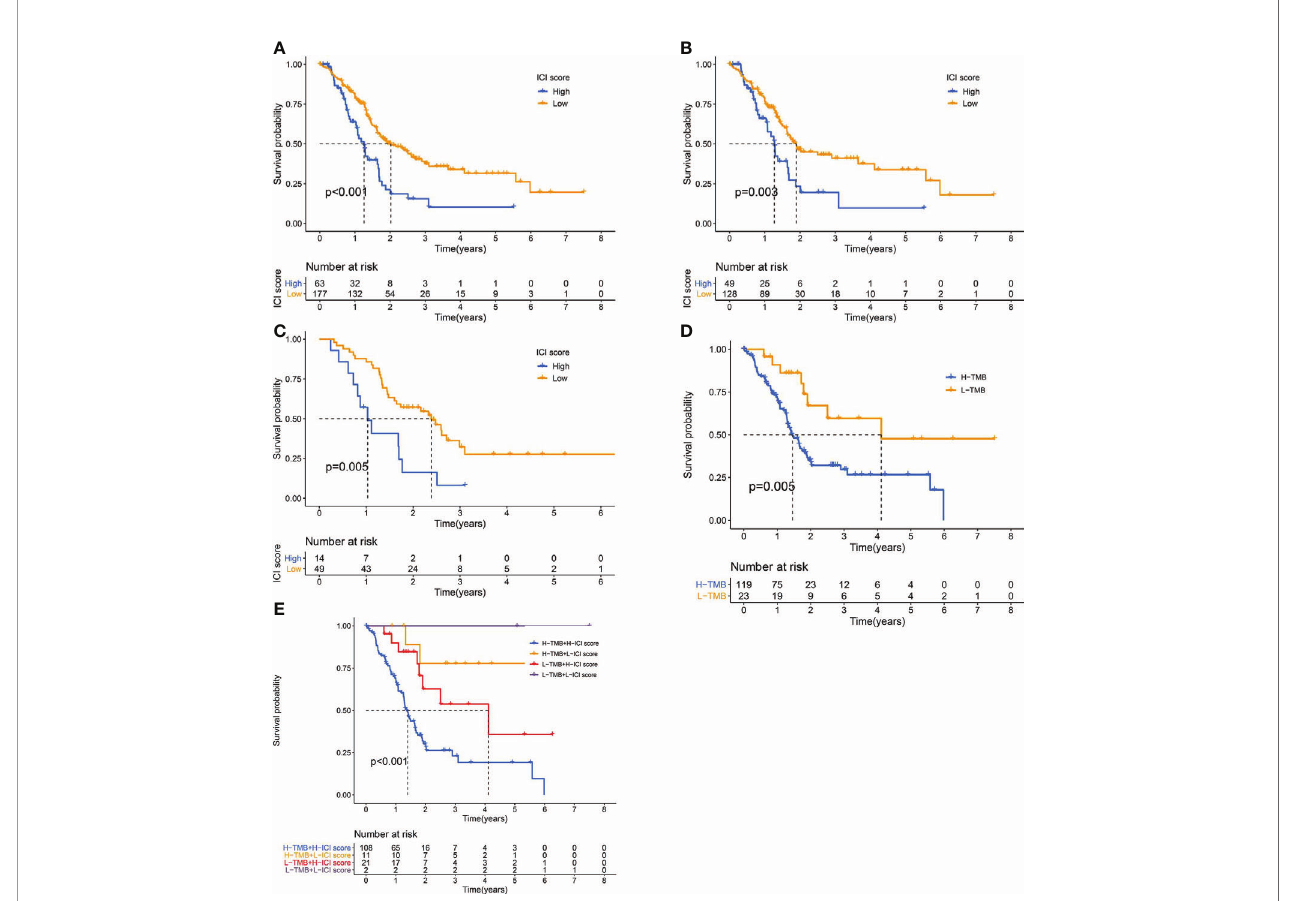
FIGURE 5 | The Signi fi cance of the ICI Scores in PC prognosis. (A-C) Kaplan-Meier curves for high and low ICI score subgroups (A) for TCGA and GEO cohorts, Log-rank test, P <0.001; (B) for TCGA cohort, Log-rank test, P =0.003; (C) for GEO cohort, Log-rank test, P =0.005). (D) Kaplan-Meier curves for high and low TMB subgroups of the TCGA cohort, Log-rank test, P =0.005. (E) Kaplan-Meier curves for patients in the TCGA cohort, classi fi ed by both TMB and ICI scores, Log-rank test, P